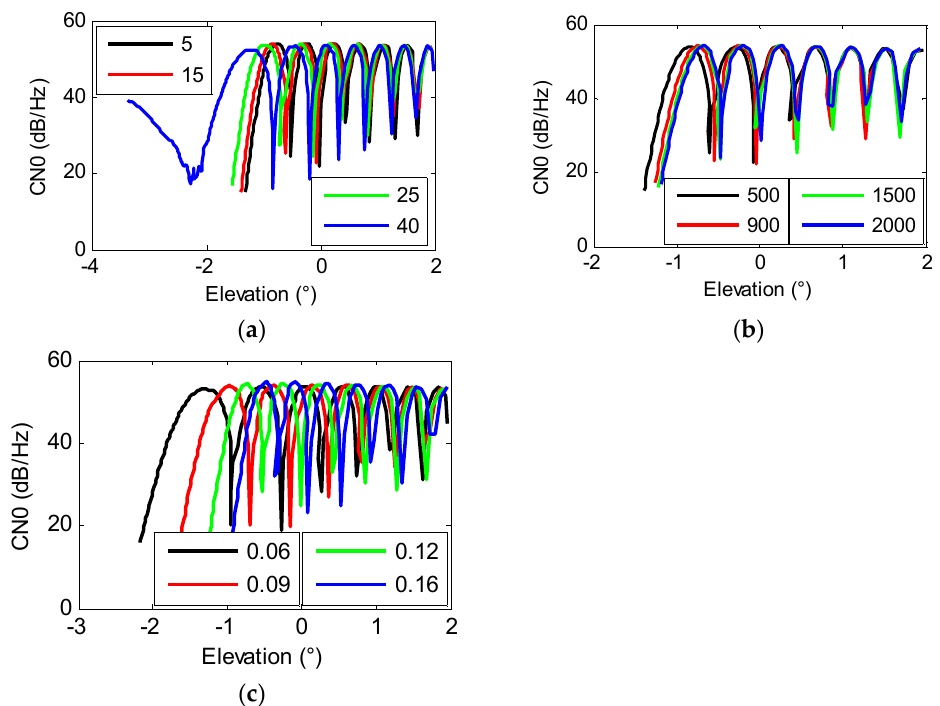
Figure 10. Influence of different duct parameters, ( a ) = EDS, ( b ) = EDTH, and ( c ) = FLS), on GNSS signal.